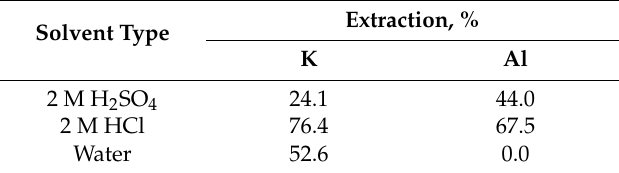
Table 3. The effect of solvent type on K and Al dissolution after the roasting process.